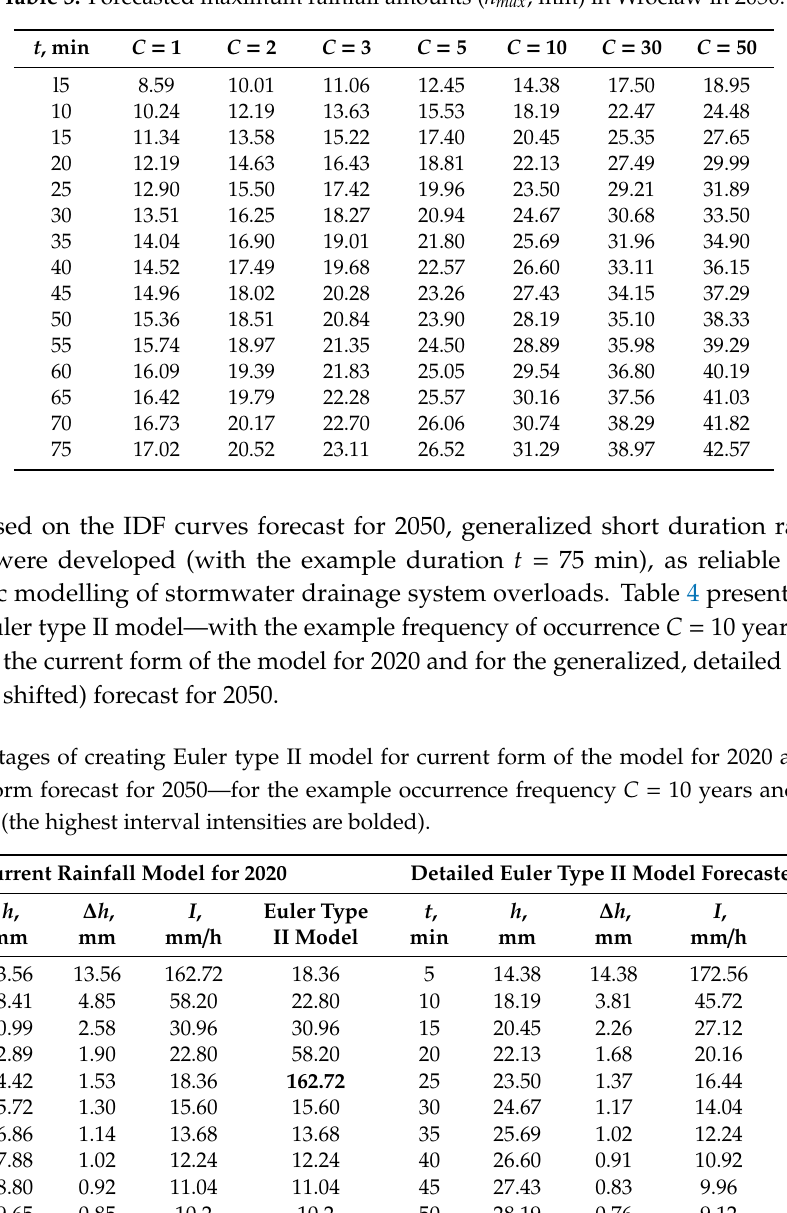
Table 3. Forecasted maximum rainfall amounts ( h max , mm) in Wrocław in 2050.